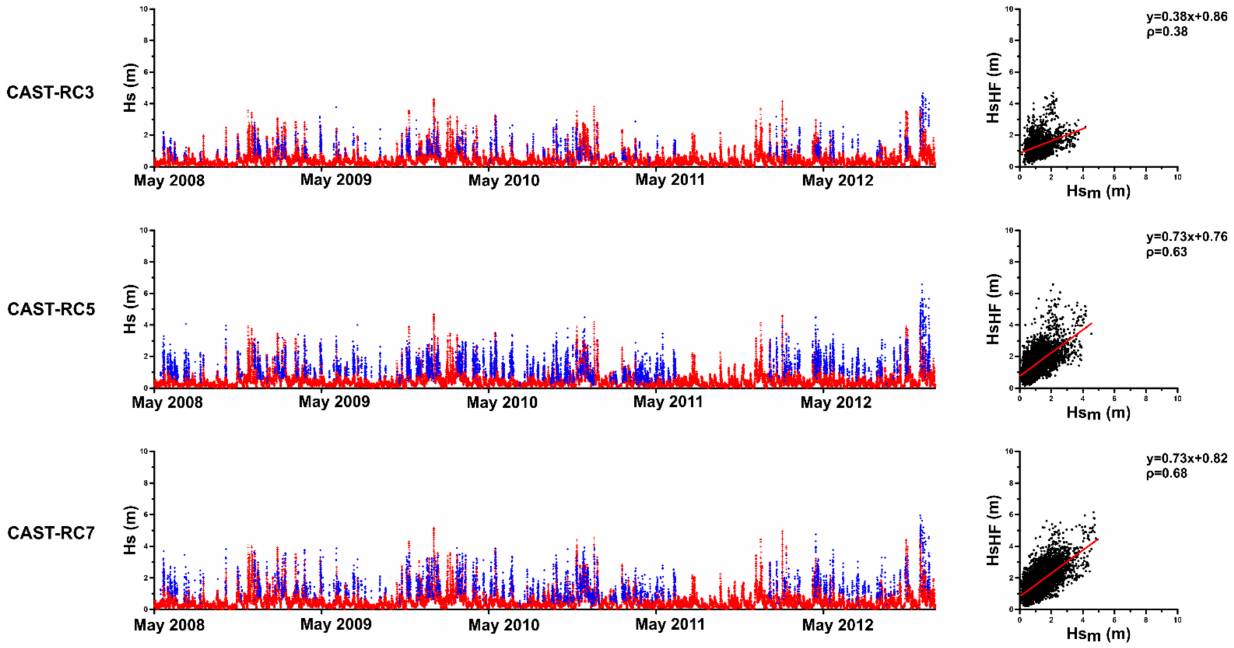
Figure 3. ( left ) Time series comparison of wave heights (Hs) between CAST HFr (blue) and MWM (red) from RC3, RC5 and RC7 (upper, middle and lower panel, respectively). ( right ) Scatter plots of Hs values recorded by the HFr and retrieved by using the MWM model at the three